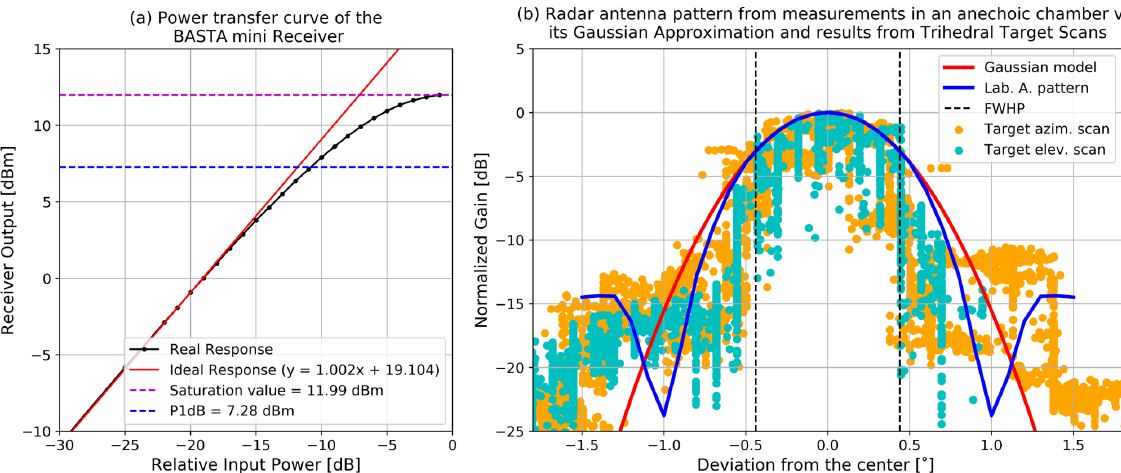
Figure 4. (a) Power transfer curve of the BASTA mini receiver. Input power is relative to the minimum attenuation value of the curve characterization experiment. All our signal retrievals from the target are slightly under the 5dBm line; thus, the correction required due to compression effects is small ( < 0 . 3dB). (b) Normalized antenna pattern of the BASTA mini antennas. We can observe that the Gaussian fit with a beamwidth of θ = 0 . 88 ◦ is very close to the antenna gain curve measured at the manufacturer’s laboratories. This figure also shows the results from mast scans around the target for comparison with the theoretical curves. To enable the comparison with the laboratory antenna pattern, we assume that the gain of both antennas is identical. Then, the received power in decibels per milliwatt is normalized with respect to the maximum measured value and divided by two to represent the gain of a single